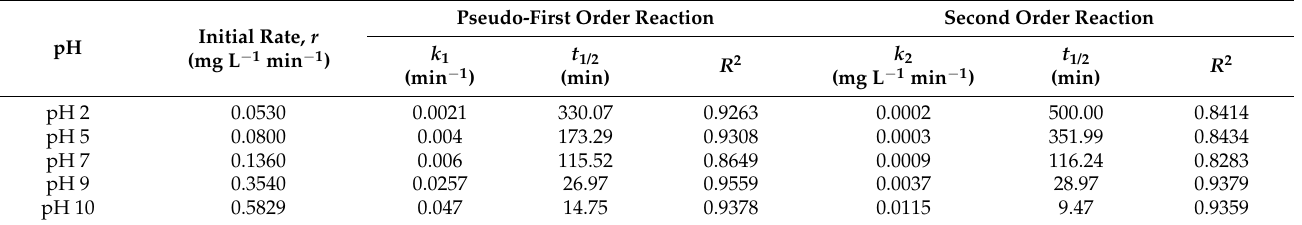
Table 2. Kinetic parameters based on the plasmonic photocatalytic reaction of Ag/AgCl with methylthioninium chloride under visible light at various pH 1